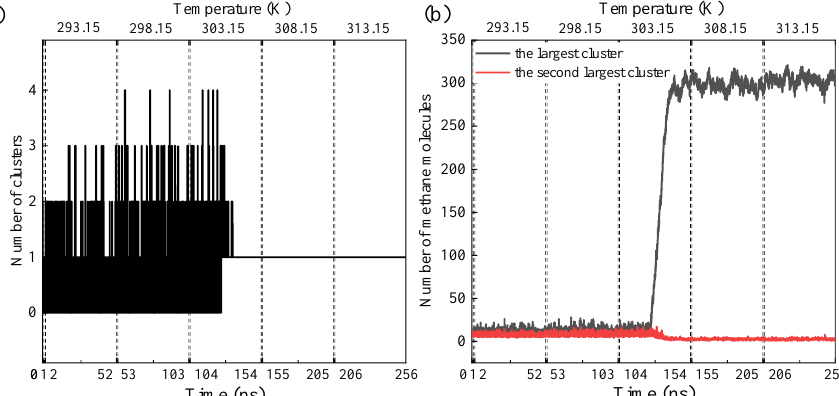
Figure 2. Time evolutions of ( a ) the number of methane clusters with N methane values larger than 10 and ( b ) N methane values in the largest and the second largest methane clusters in Sys3_5MPa.